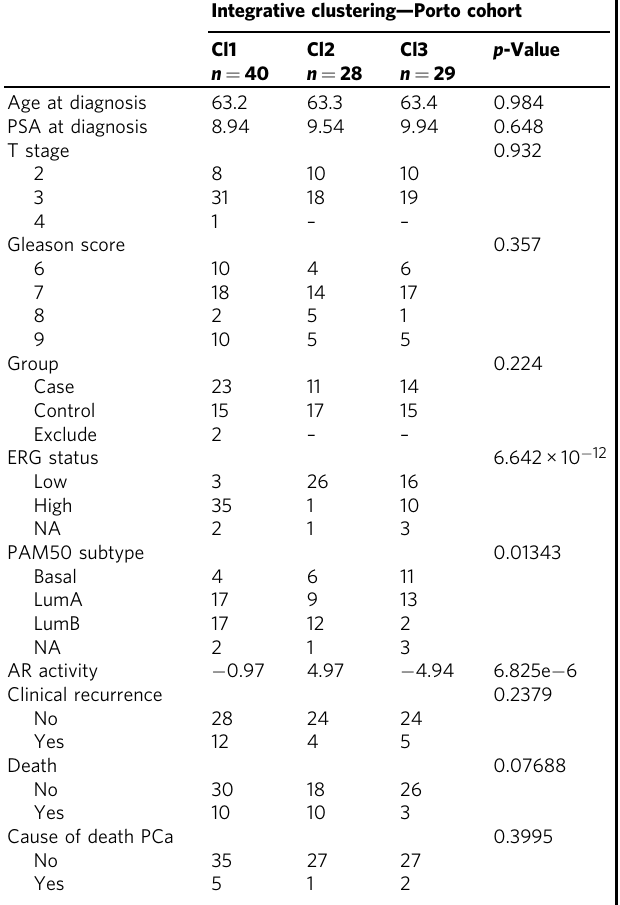
Table 2 Patient characteristics by integrative clusters — Porto cohort